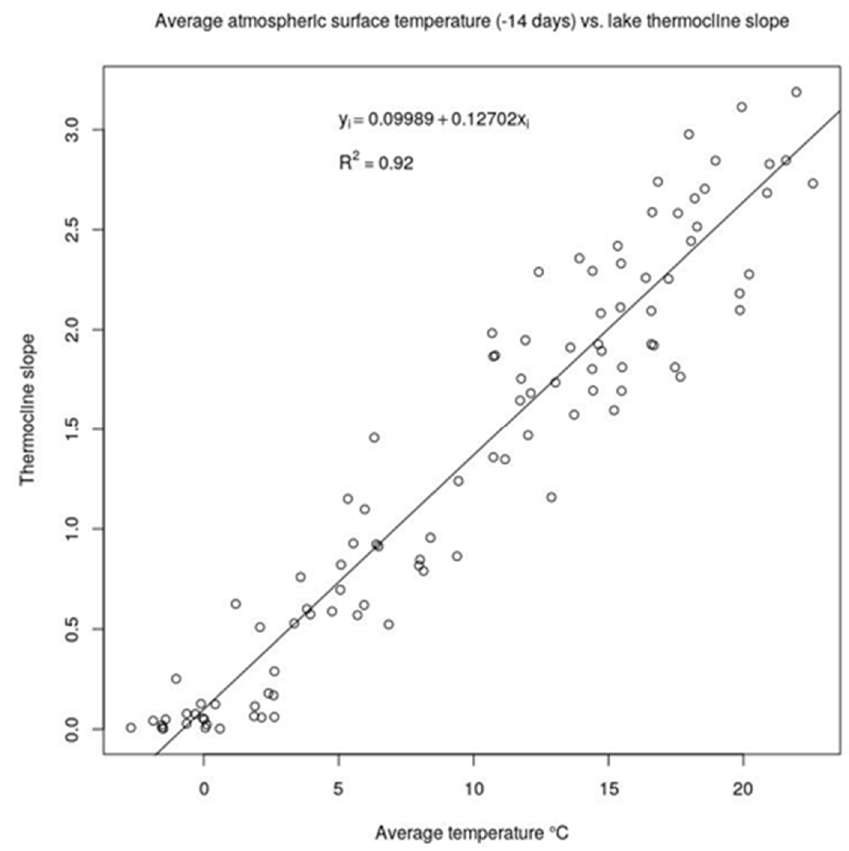
Figure 4. Relationship between the thermocline slopes and the average air temperature of current plus the preceding 14 days. Every dot is from a probe sampling campaign (from 2003 to 2015 included). The linear relationship is strong (R 2 = 0.92) and without any relevant bias in the plot, thus supporting the use of the average air temperature of the current and the last 14 days as a proxy of water stratification. Table 3. Multiple linear regression (MLR) models of cyanobacteria biovolume (LOG CyanoBV) using the 14-days mean air temperature (T14) and one of the physical–chemical variables listed in Table S1 of SI (AN: Ammonium nitrogen; CD: Conductivity; TP: Total phosphorous; SD: Secchi disk depth; and pH). The statistical significance of each coe ffi cient is indicated when below 0.1 ( p -values: ***: 0.001; **: 0.01; *: 0.05; ◦ , 0.1). For each model the coe ffi cient of determination (R 2 ), the adjusted R 2 (R 2 adj), and the F statistic are reported. LOG means ten-based